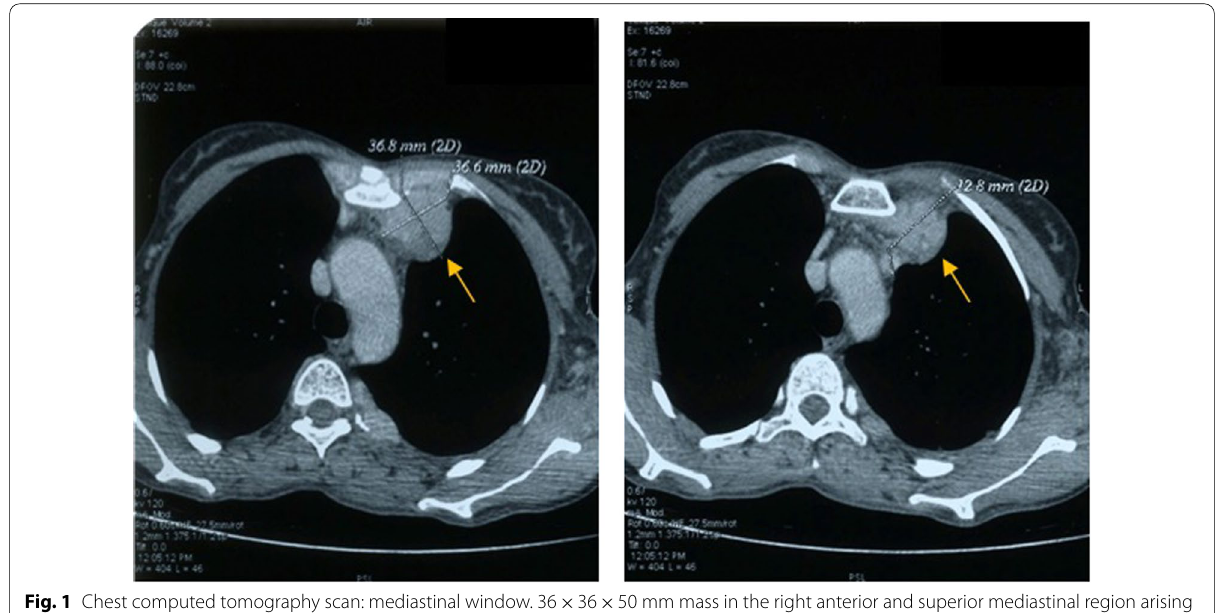
36 50 mm mass in the right anterior and superior mediastinal region arising × ×